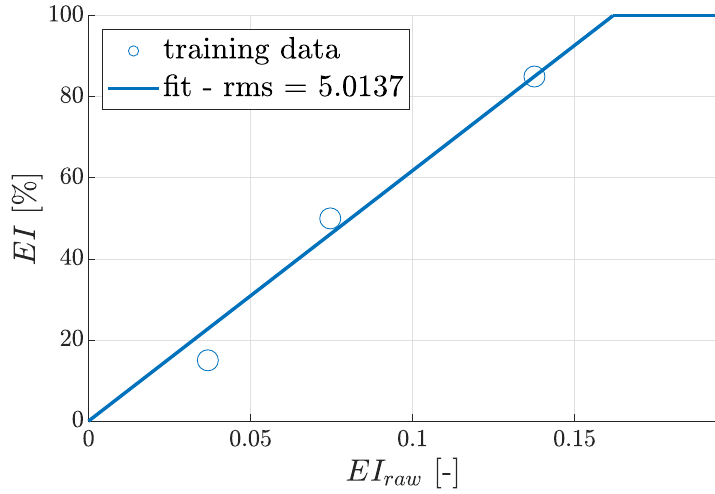
Figure 12. Eco Index calibration